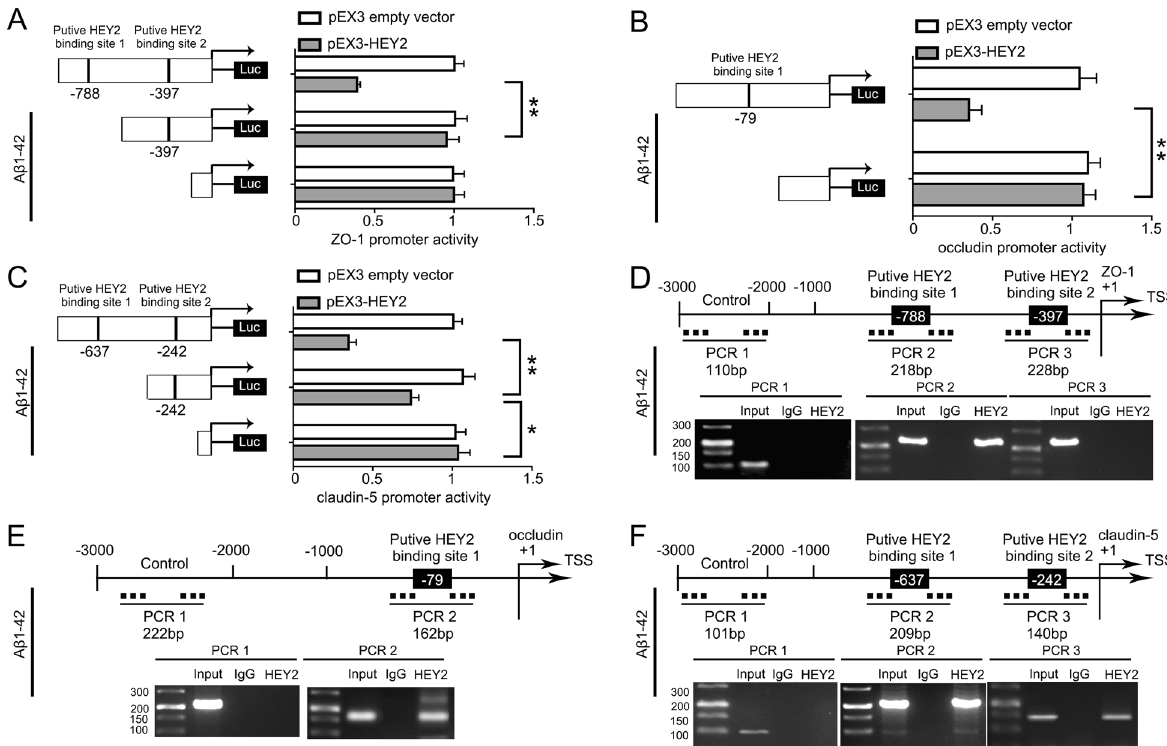
Fig. 6 HEY2 decreased the Promoter Activity of ZO-1, occludin, and claudin-5 in ECs pre-incubated with A β 1 – 42 . A – C Schematic depiction of the different reporter plasmids and relative luciferase activity in A β 1 – 42 microenvironment. The relative luciferase activity was conducted after A β 1 – 42 -incubated ECs co-transfected with ZO-1 A , occludin B , or claudin-5 C promoter ( − 1000 to 0 bp) (or promoter-deleted putative HEY2-binding sites) with pEX3-HEY2 or pEX3 empty vector. Data represent mean ± SD ( n = 3, each). ** P < 0.01, * P < 0.05. D – F HEY2 interacted with the promoters of ZO-1 D , occludin E , and claudin-5 F in A β 1 – 42 -incubated ECs. The transcription start site (TSS) was designated as + 1. Putative HEY2-binding sites are illustrated. Immunoprecipitated DNA was ampli fi ed by PCR. Normal rabbit IgG was used as a negative